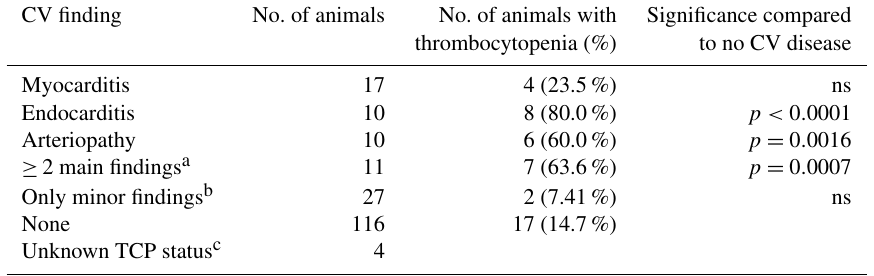
Table 2. Incidence of cardiovascular (CV) disease in relation to thrombocytopenia (TCP) in SIV-infected rhesus macaques ( Macaca mulatta ). CV finding No. of animals No. of animals with Significance compared thrombocytopenia (%) to no CV disease Myocarditis 17 4 (23.5%) ns Endocarditis 10 8 (80.0%) p < 0 . 0001 Arteriopathy 10 6 (60.0%) p = 0 . 0016 ≥ 2 main findings a 11 7 (63.6%) p = 0 . 0007 Only minor findings b 27 2 (7.41%) ns None